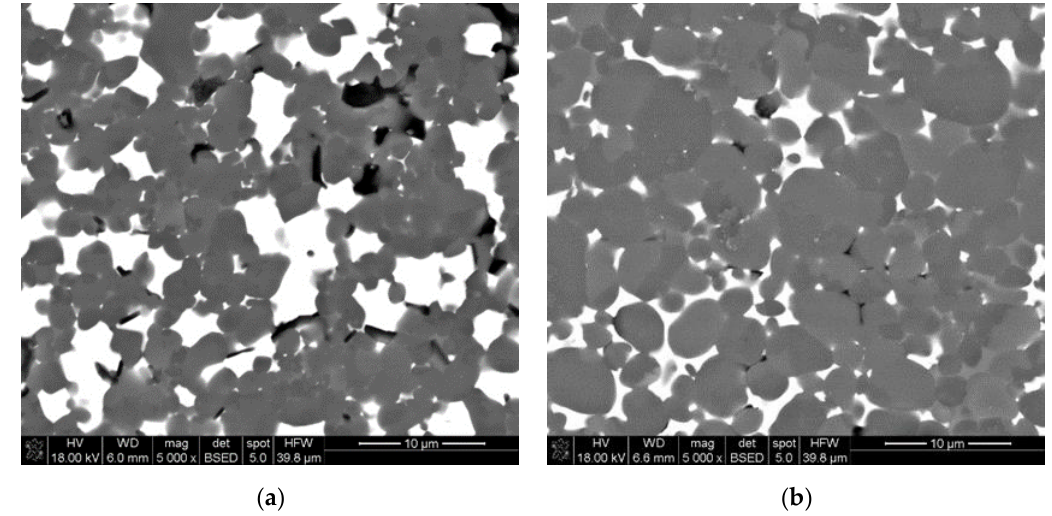
Figure 11. SEM images of sintered AlN specimens fabricated via ( a ) LCM, ( b ) uniaxial and cold isostatic pressing. isostatic